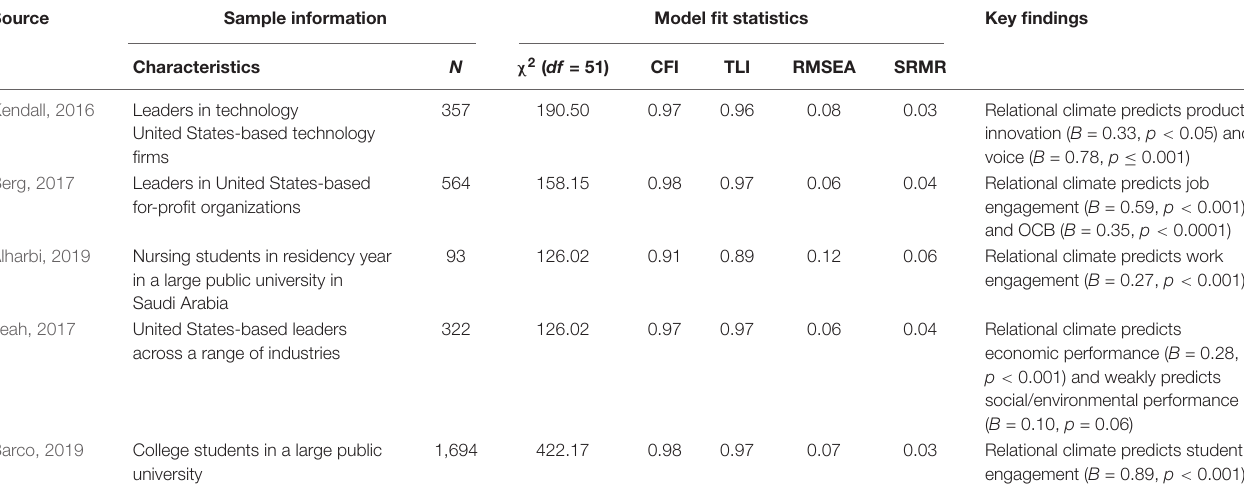
TABLE 12 | Summary of relational climate model fit statistics and findings from additional studies. Source Sample information Model fit statistics Key